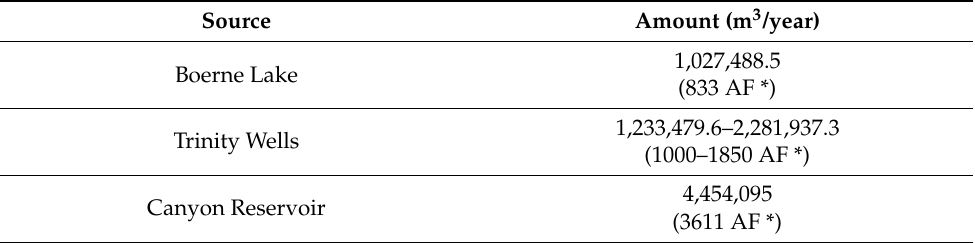
Table 1. Water Supply by